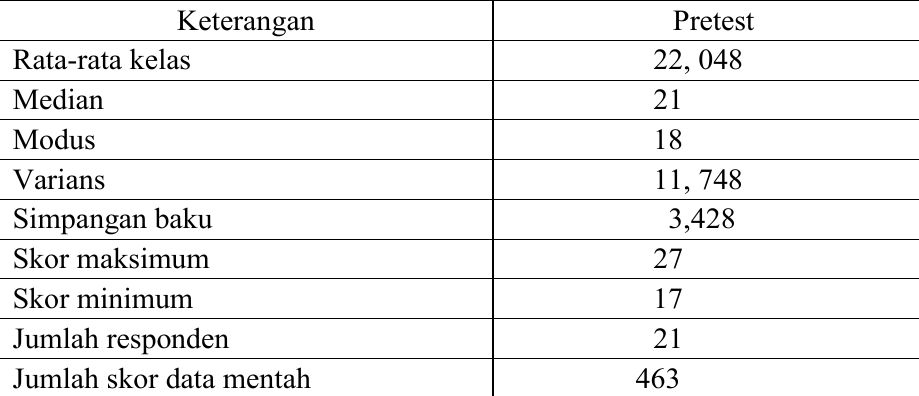
Tabel 1. Deskripsi Data Pra Penelitian